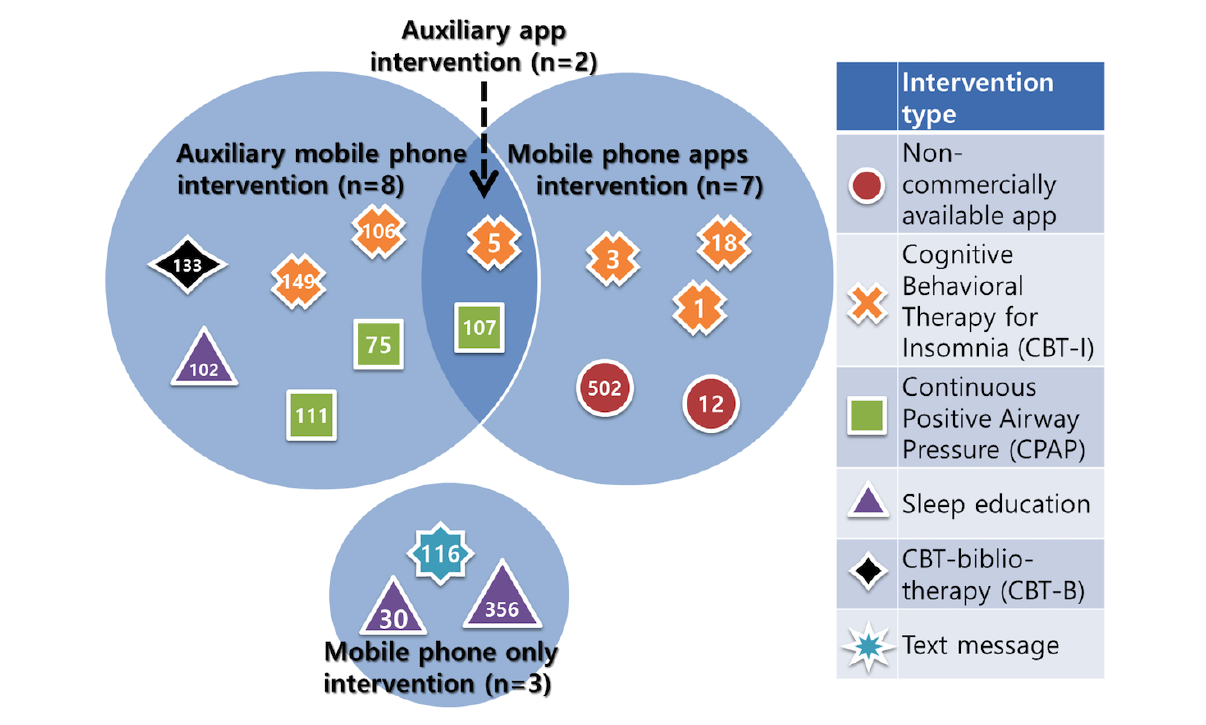
Figure 2. Sample size based on the intervention methods (N=16).